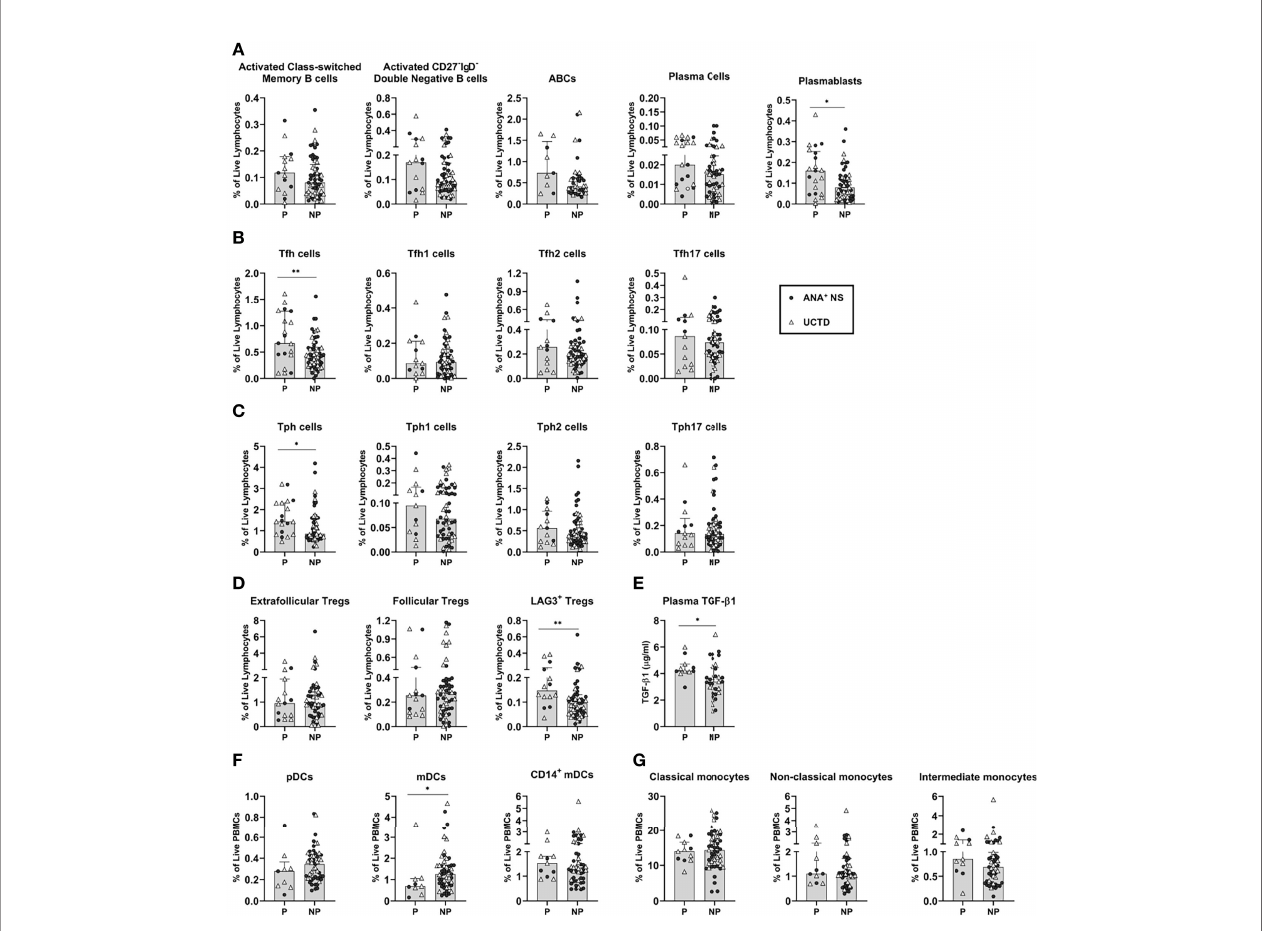
FIGURE 5 | Antinuclear antibody positive (ANA + ) individuals lacking a systemic autoimmune rheumatic diseases (SARD) diagnosis who demonstrated symptomatic progression demonstrate differences in adaptive and innate immune populations, relative to non-progressors. All graphs compare progressors and non-progressors at baseline (initial assessment). Patients diagnosed as ANA + NS or UCTD at initial assessment are represented by the closed circles and the open triangles, respectively. (A) B cell subsets. (B, C) T helper cell subsets. (D) T regulatory cell subsets. (E) Plasma transforming growth factor beta-1 (TGF- b 1) levels. (F) Dendritic cell subsets. (G) Monocyte subsets. Bars represent the median with interquartile range. Each data point represents an individual subject. For each set of comparisons, statistical signi fi cance was determined using the Mann-Whitney test. *p ≤ 0.05, **p ≤ 0.01. P, Progressors; NP,